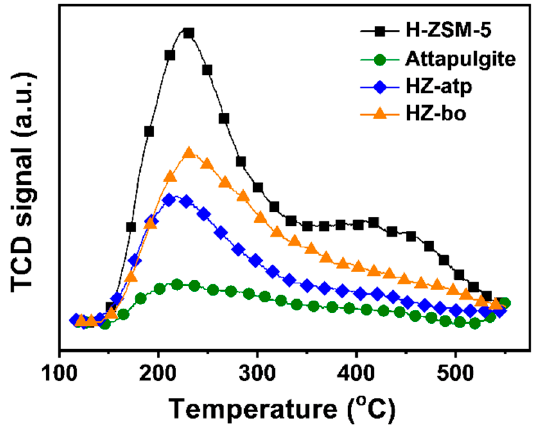
Figure 6. NH 3 -TPD profiles of H-ZSM-5 zeolite and HZ-atp and HZ-bo extrudates.